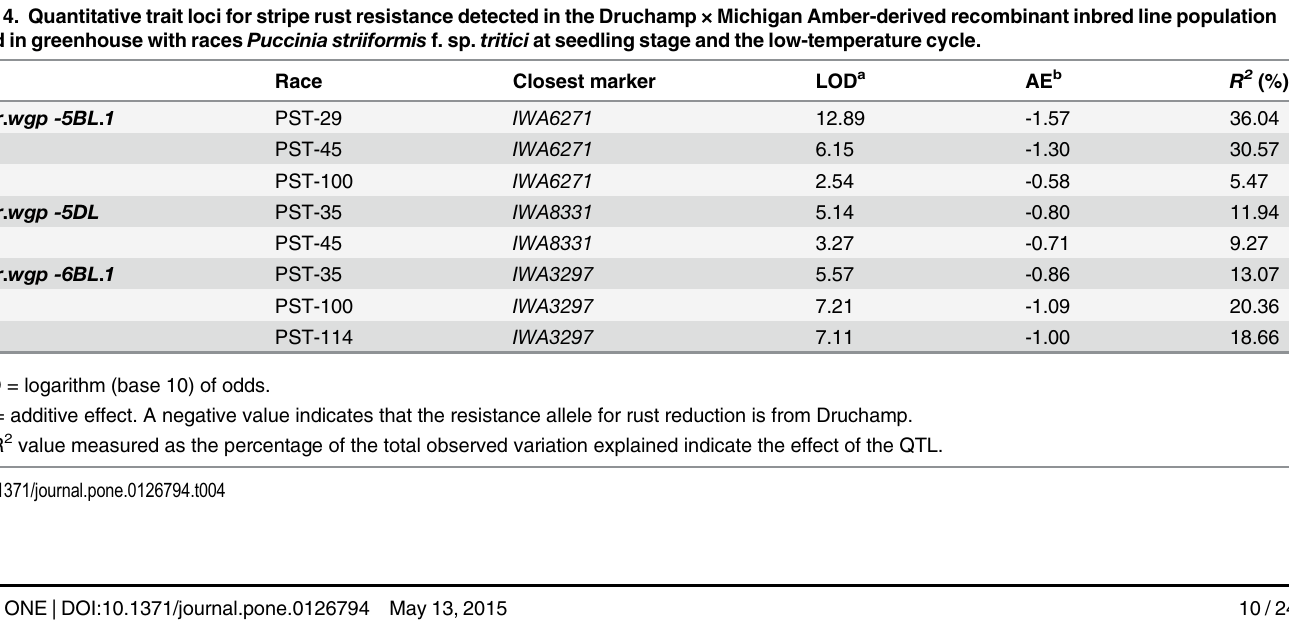
Table 4. Quantitative trait loci for stripe rust resistance detected in the Druchamp × Michigan Amber-derived recombinant inbred line population tested in greenhouse with races Puccinia striiformis f. sp. tritici at seedling stage and the low-temperature cycle. QTL QYrdr . wgp -5BL . 1